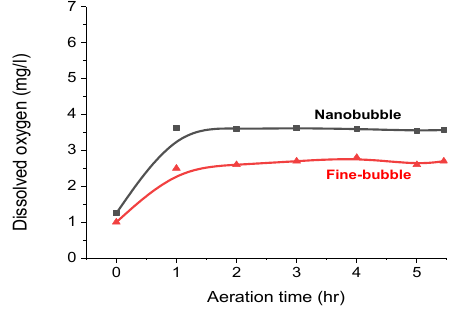
Fig. 5. Changes in Dissolved Oxygen in Reactor Mixed Liquor (SRT=40 d, COD=800 mg/l).